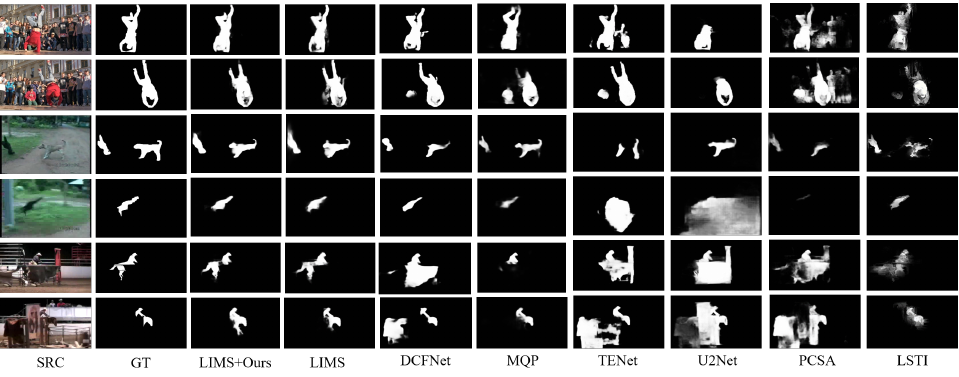
Figure 7. Comparison of saliency maps generated by different VSOD models, “LIMS+Our” refers to the saliency map generated by fine-tuning the LIMS model using the optical flow model proposed in this